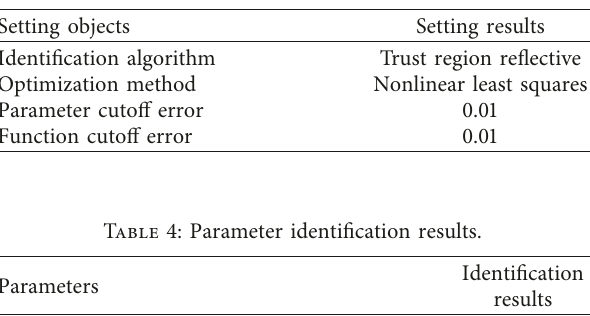
Figure 6: Force output curve at 0.1Hz frequency. Table 3: Correlation settings of the parameter identification algorithm.